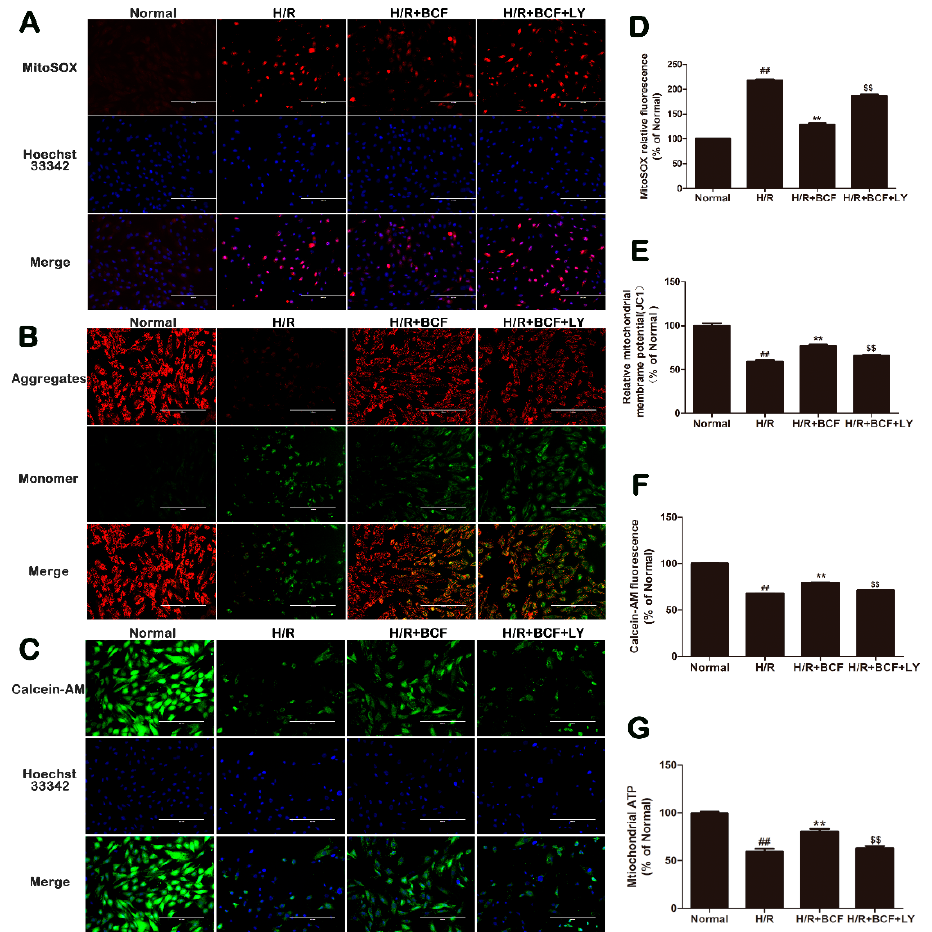
Figure 4. Effects of BCF on ROS-generating mitochondria, ∆Ψ m, mitochondrial ATP production, and MPTP opening levels. ( A ) Mitochondria-associated ROS levels were detected by staining cells with MitoSOX (red). Nuclei were stained with blue-fluorescent Hoechst 33342; ( B ) Depolarization of ∆Ψ m was measured by Fluorescence Microscope using JC-1 probe; ( C ) Changes of MPTP opening in H9c2 cardiomyocytes were detected by calcein-AM (green) as a fluorescence indicator by fluorescence micrographs. Nuclei were stained with blue-fluorescent Hoechst 33342. The scaleplate represents 200 µ m. All quantitative analysis of the florescence intensity was detected by a microplate reader. The corresponding histograms ( D , E , F ) were displayed. ( G ) Mitochondrial ATP production in H9c2 cardiomyocytes was determined using the ATP assay kit. Values were represented as mean ± SD ( n = 6, each group). ## p < 0.01 vs. normal; ** p < 0.01 vs. H/R-treated cells; $$ p < 0.01 vs. H/R + BCF-treated cells.